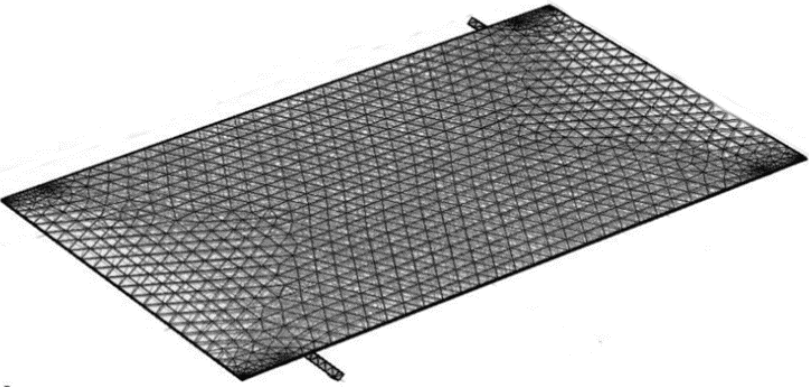
Figure 4. PV / T element with finite element meshing. Figure 4. PV/T element with finite element meshing. Table 5. Grid independence